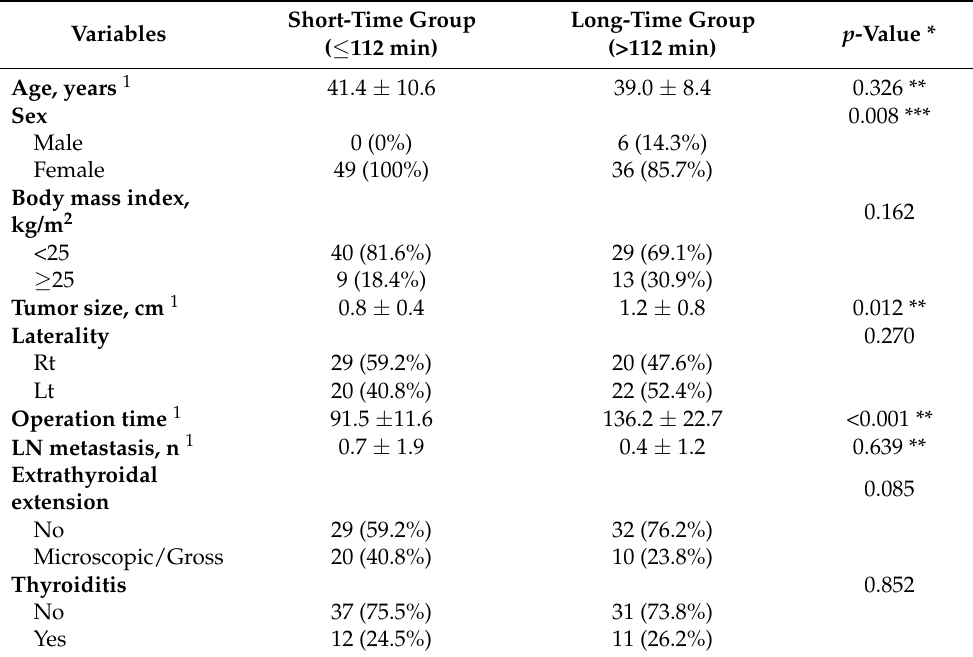
Table 3. Clinicopathologic characteristics of patients according to groups classified by operation time in patients who underwent lobectomy for malignancy.